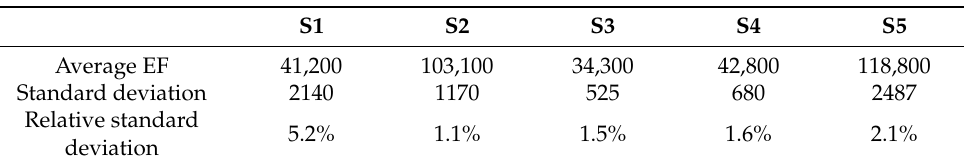
Table 5. Average enhancement factor and the (relative) standard deviation derived from enhancement maps of